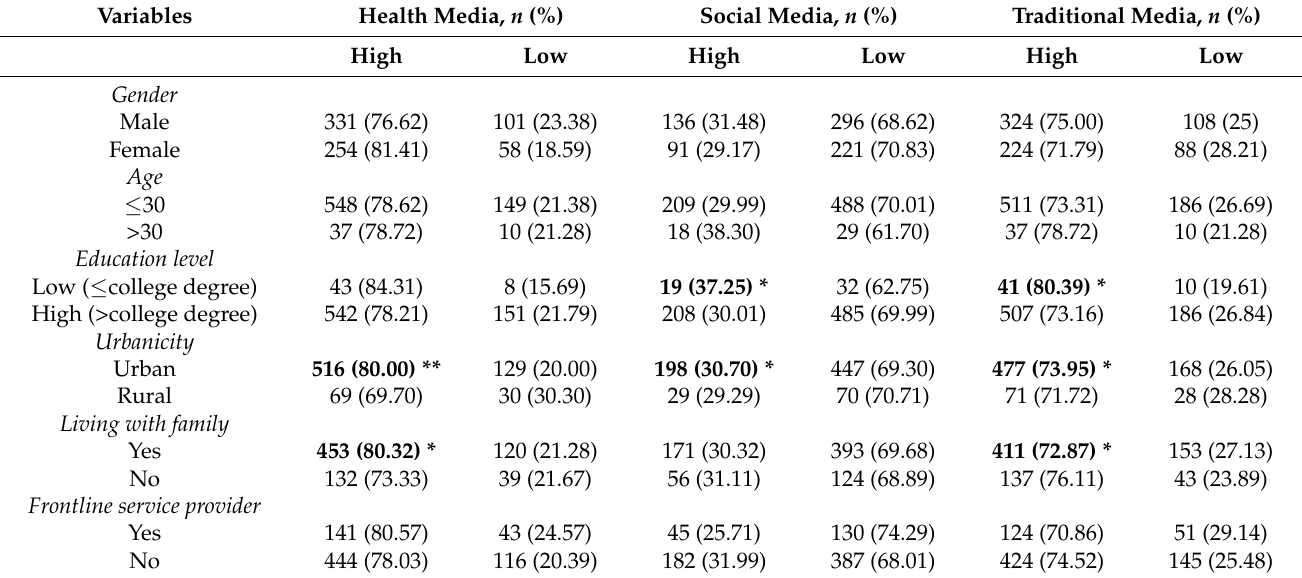
Table 2. Levels of perceived trust in COVID-19 information sources across sociodemographic, residency, and frontline service status groups ( n =